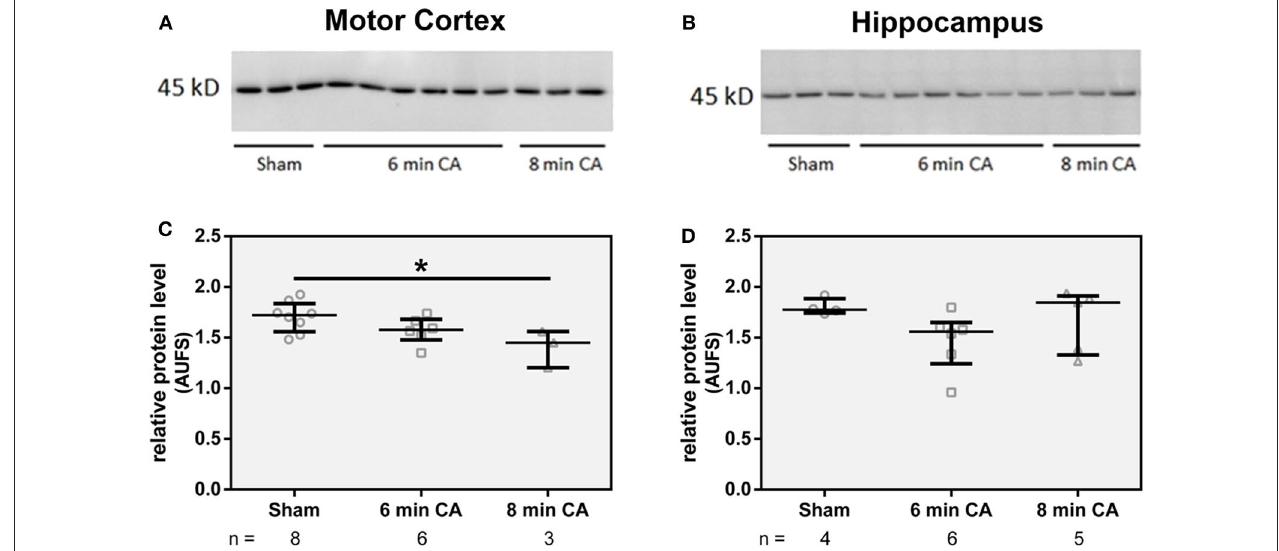
FIGURE 4 | Abundance of HO-2 in homogenates of mC (A) and Hc (B) . Homogenates from brain regions of single animals were analyzed by SDS-PAGE and immunostained for HO-2 as described in Materials and Methods section. For quantification, band intensities of HO-2 specific staining were normalized to total protein staining of the respective gel lanes, in (C) for mC and in (D) for Hc. Values are given as AUFS (arbitrary units) as single data (gray open symbols) for each group: sham animals (open circles), rats subjected to cardiac arrest (CA) for 6min (CA 6min, open squares) or 8min (CA 8min, open triangles), indicating additionally group medians (thin black line) and 1st and 3rd quartiles (bold black lines). The numbers of analyzed animals per group are indicated below the graphs; a selection is displayed here. Total protein patterns of the respective gels are shown in Figure S1 . Differences between groups are indicated (one-way non-parametric ANOVA (Kruskal Wallis) Bonferroni-corrected; * p < 0.01).